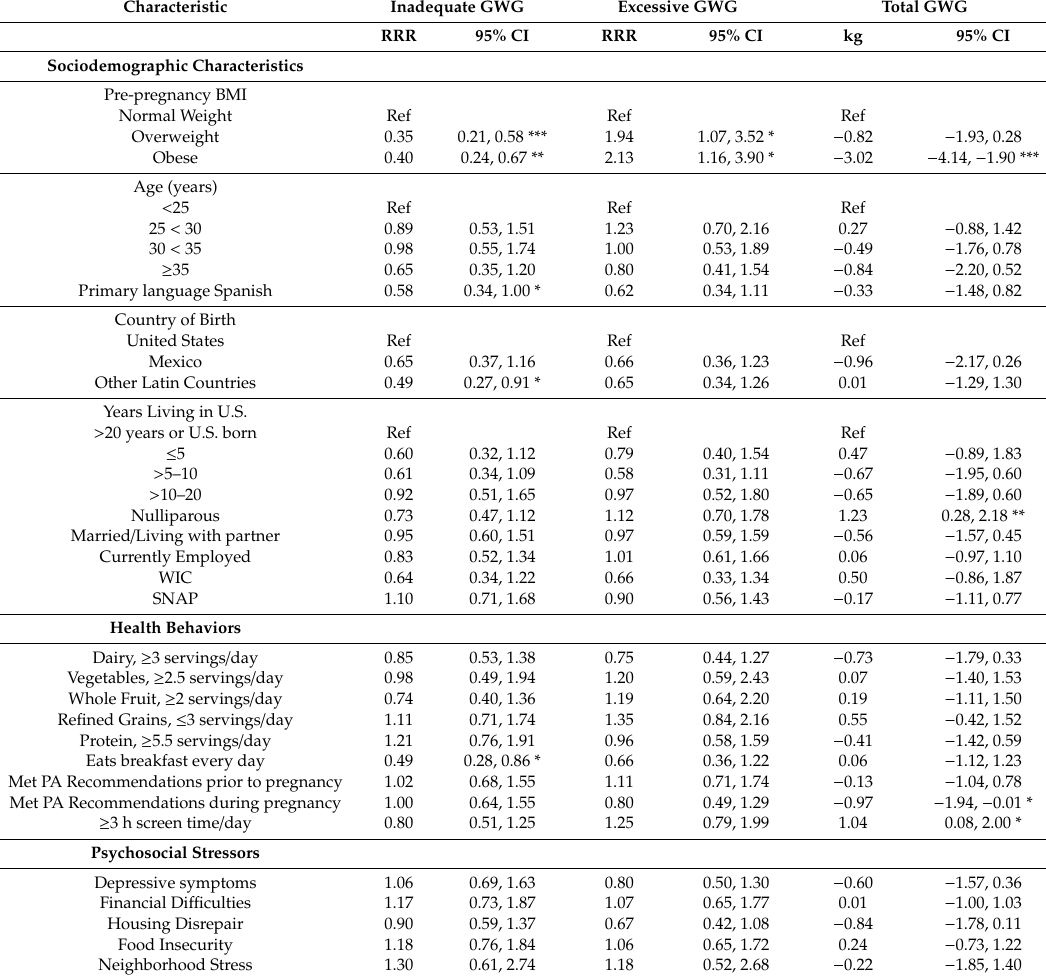
RRR, relative risk ratio; CI, confidence interval; GWG, gestational weight gain; BMI, body mass index; SNAP, Supplemental Nutrition Assistance Program; WIC, Women, Infant and Children; PA, physical activity. For multinomial regression, reference is adequate GWG. All models are adjusted for pre-pregnancy BMI. Model for Whole grains, ≥ 3 servings / day omitted due to small numbers ( n < 5). * p values are indicated with asterisks, with * p < 0.05, ** p < 0.01, *** p <